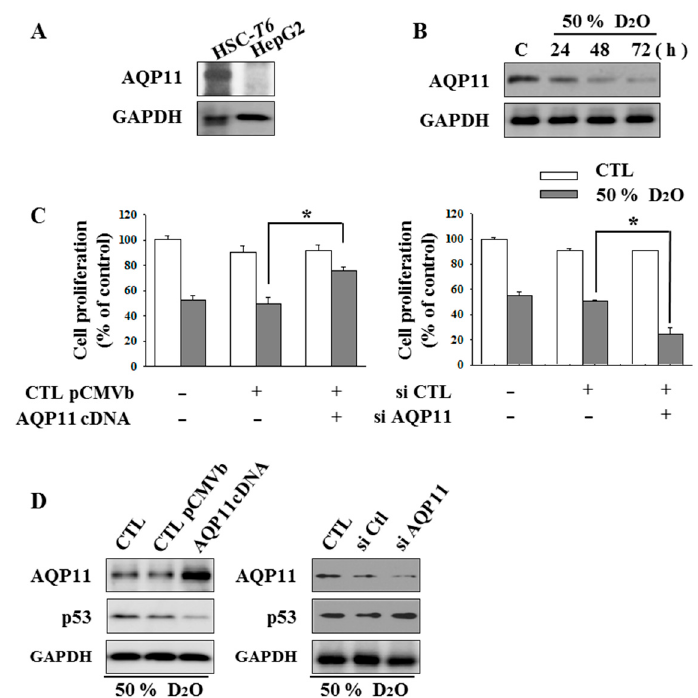
Figure 2. Downregulation of aquaporin (AQP) 11 by deuterium oxide (D 2 O) had an antiproliferative effect on activated hepatic stellate cells (HSCs). AQP11 is expressed in HSC-T6 cells, but not HepG2 cells, as assessed by western blotting ( A ). Intracellular levels of AQP11 were measured by western blotting of lysates from HSC-T6 cells treated with 50% D 2 O for 24, 48, or 72 h ( B ). HSC-T6 cells were transfected with a plasmid containing the AQP11 cDNA or an AQP11-targeted siRNA and then incubated with 50% D 2 O, after which the cells were dyed with crystal violet, and absorbance at 570 nm was quantified to assess cell proliferation ( C ). The expression of AQP11 and p53 was assessed by western blotting. GAPDH served as a loading control ( D ). Data are representative of three independent experiments and are expressed as mean ± SD, * p < 0.05.